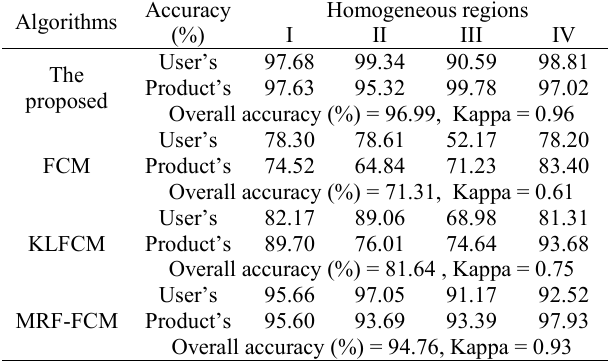
Table 1. Quantitative analysis